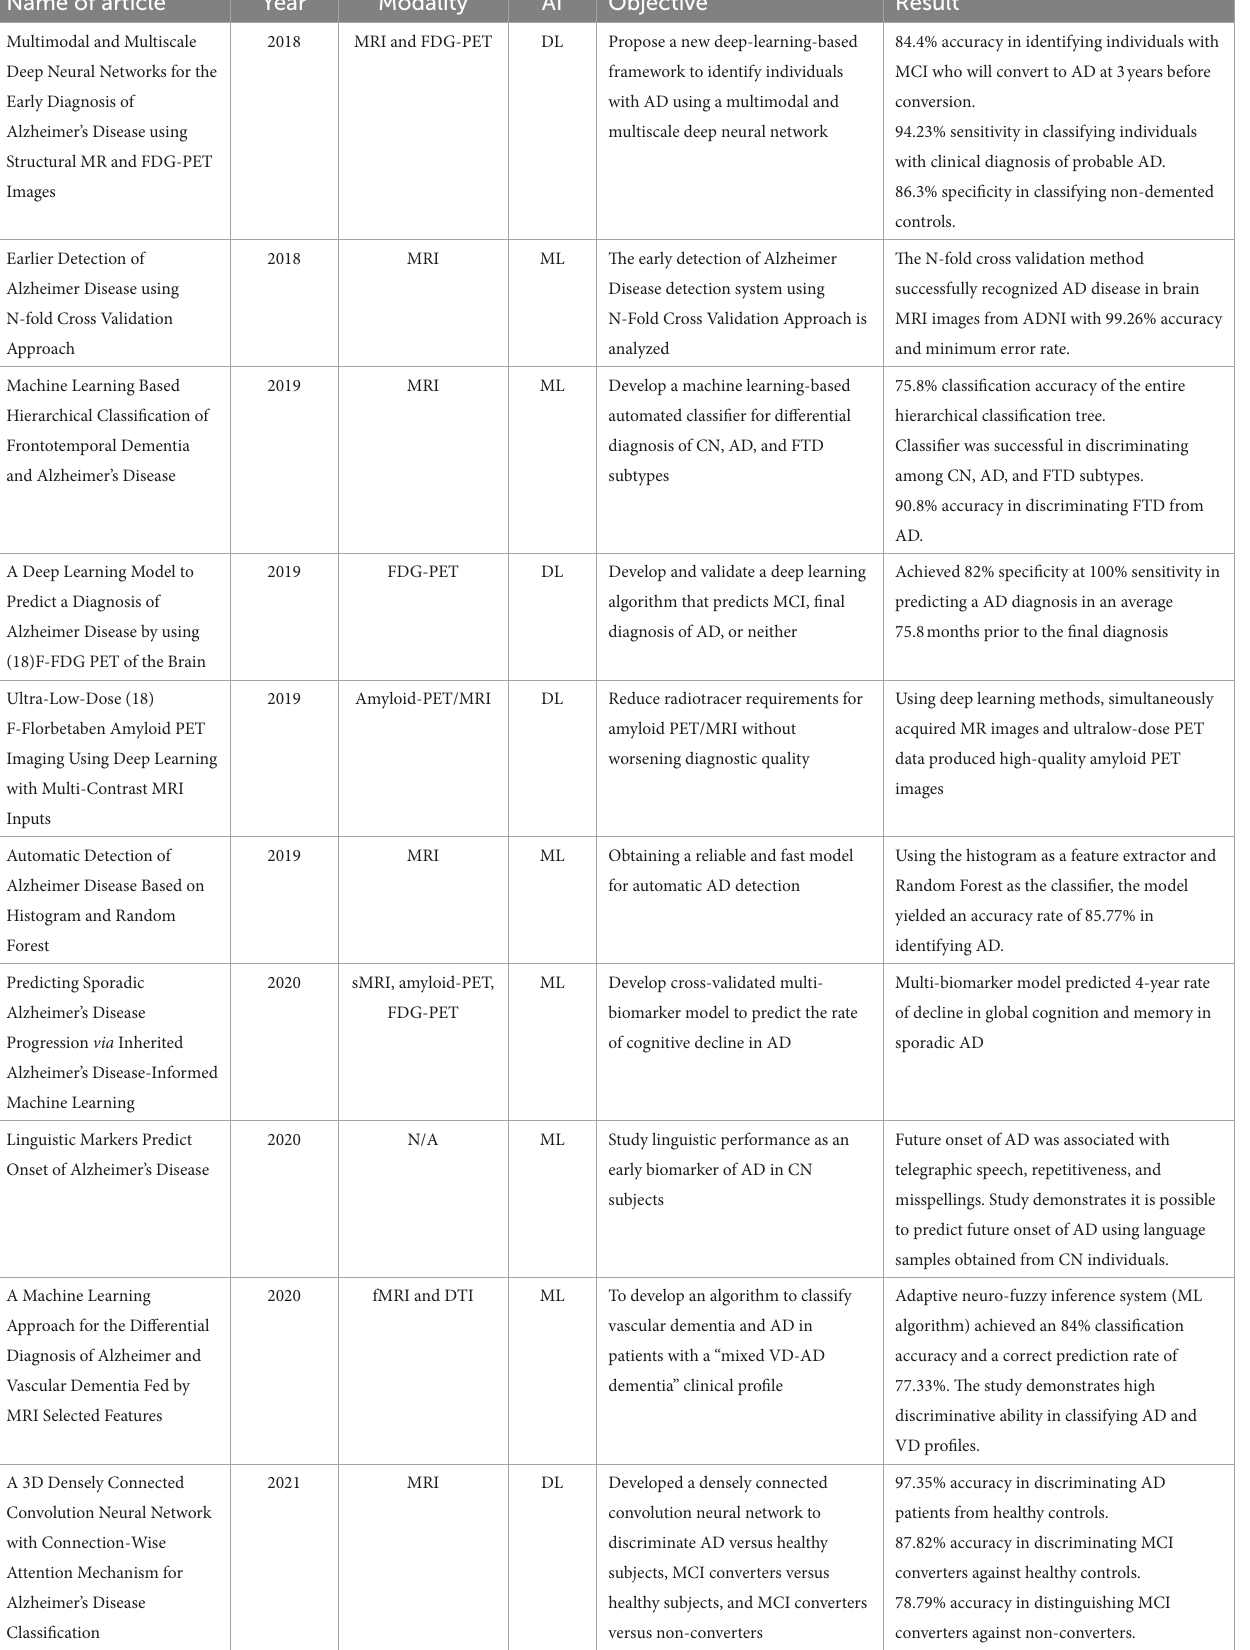
TABLE 1 Summary of artificial intelligence research in Alzheimer’s